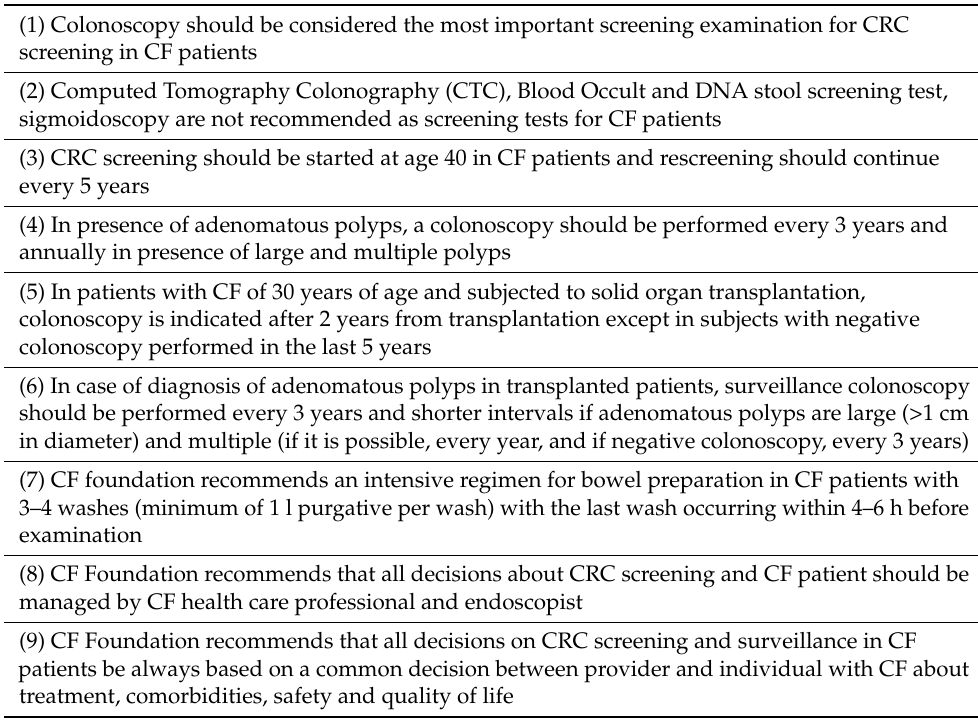
Table 1. The nine rules to respect regarding colon rectal cancer (CRC) in cystic fibrosis (CF)